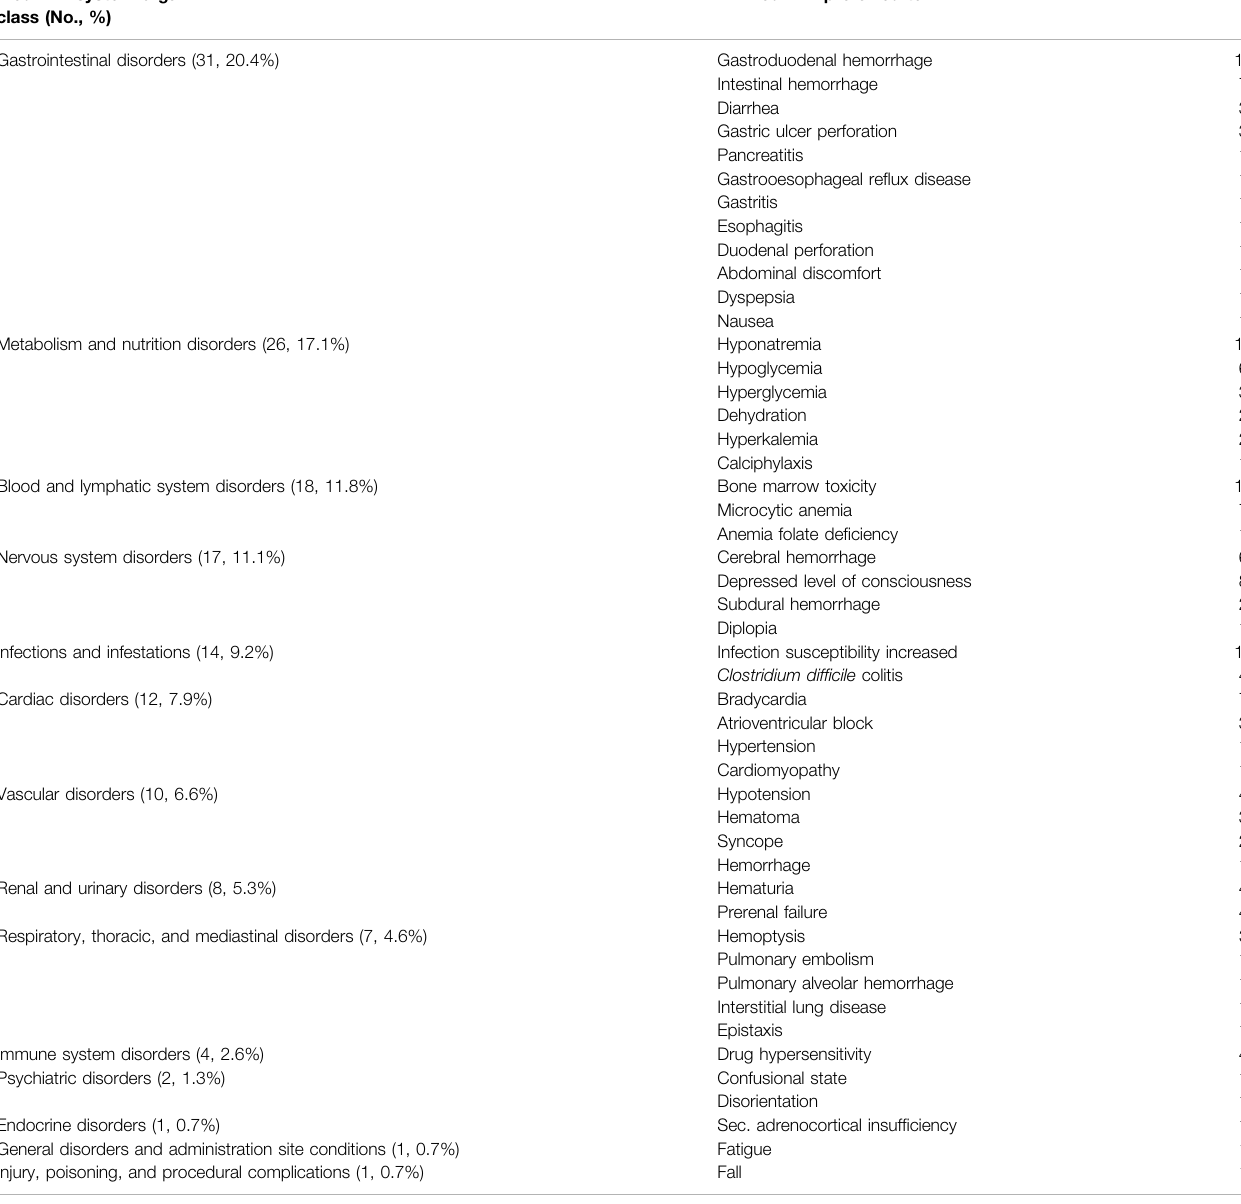
TABLE 4 | MedDRA classi fi cation of ADEs related to treatment safety (N = 152). MedDRA system organ class (No.,